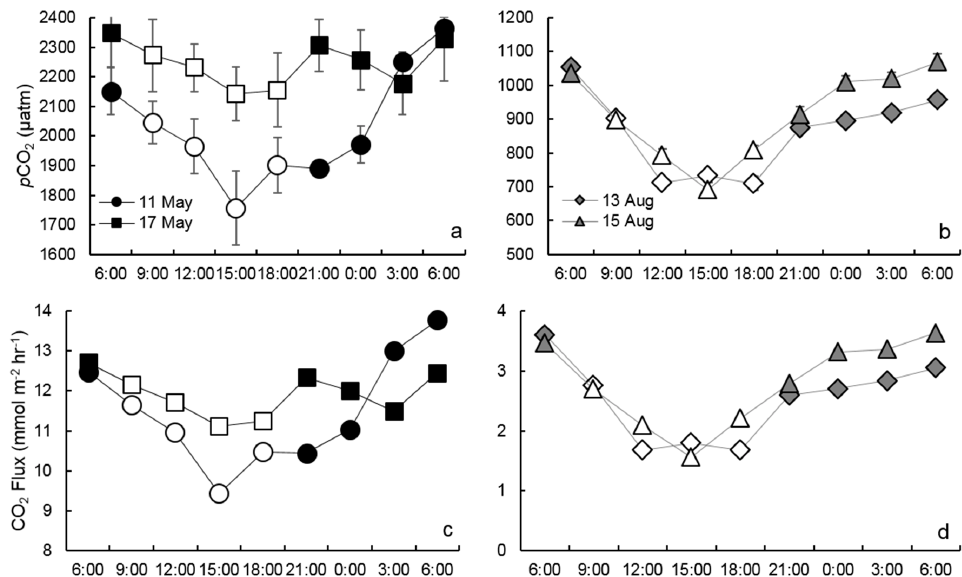
Figure 3. Daily variation in p CO 2 ( a , b ) and CO 2 flux ( c , d ) in the Lower Mississippi River during spring ( a , c ) and fall ( b , d ). Data points in ( a ) and ( b ) represent the mean p CO 2 value and error bars represent the standard deviation of the respective samples. The hollow data points represent samples collected during daylight hours (i.e., solar radiation > 0.00 kW m − 2 ). The daily hours are Central Standard Time of the United States. Table 1. Linear regressions of p CO 2 and CO 2 flux (mmol m − 2 h − 1 ) with hourly time steps (H) for 6:00